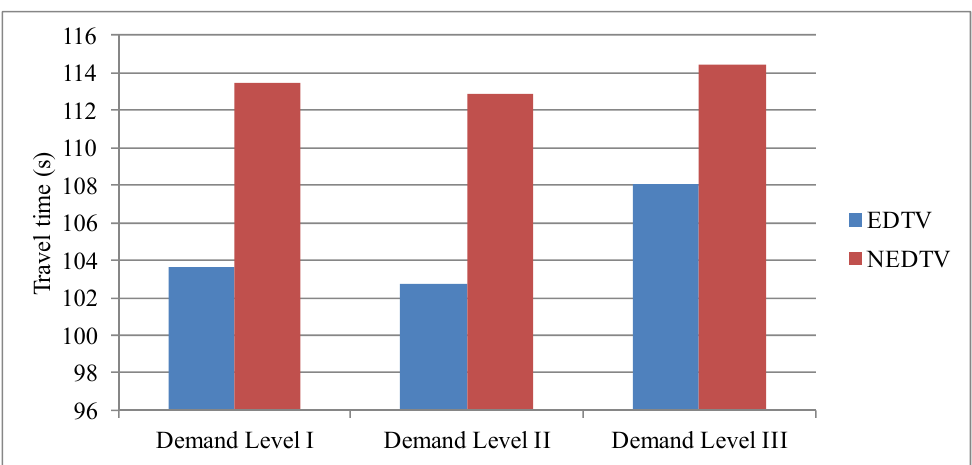
Figure 6. Travel time